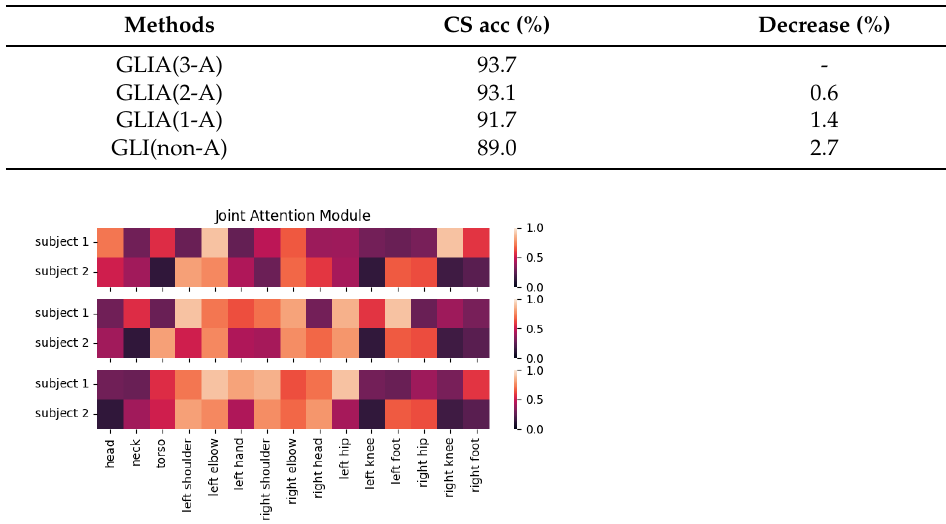
Table 6. Comparison in terms of interaaction recognition accuracy of Joint Attention Module.